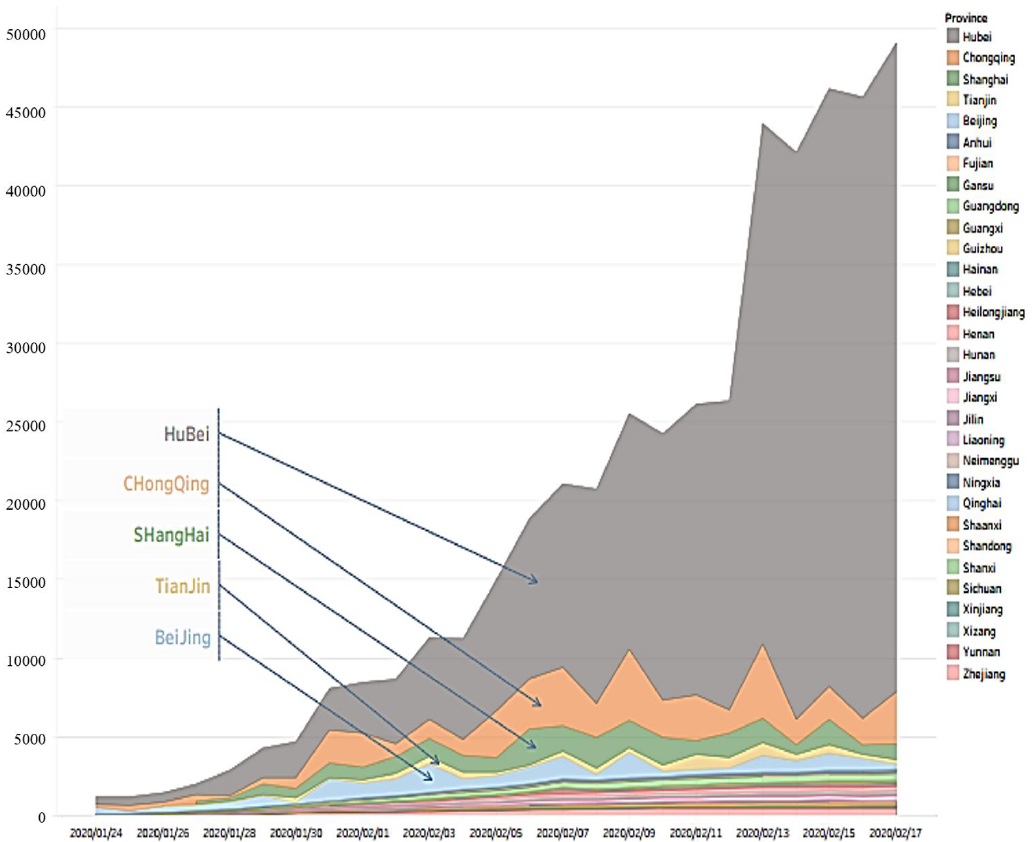
Figure 4. The changes in the number of new COVID-19 cases in various provinces of China from January 24 to February 17.